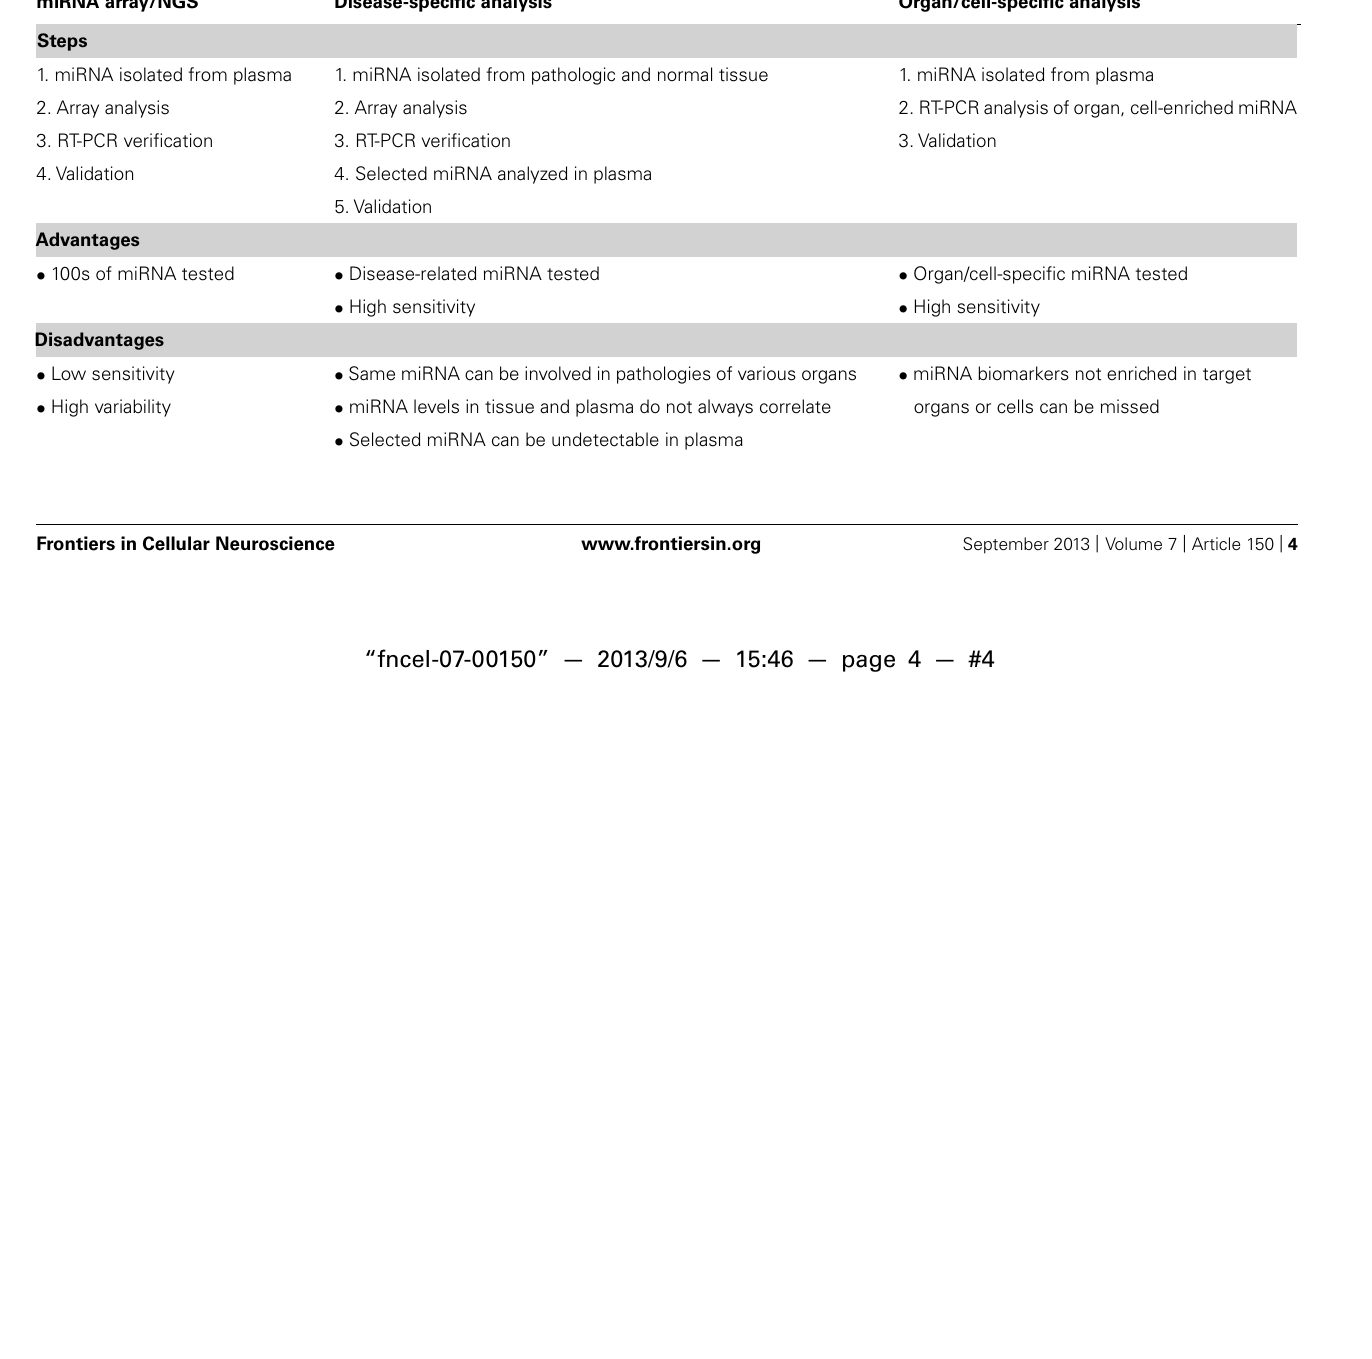
Table 1 | Current approaches to analysis of miRNA in plasma. The same approaches can be used for miRNA analysis in different body fluids (urine, saliva, and milk). miRNA array/NGS Disease-specific analysis